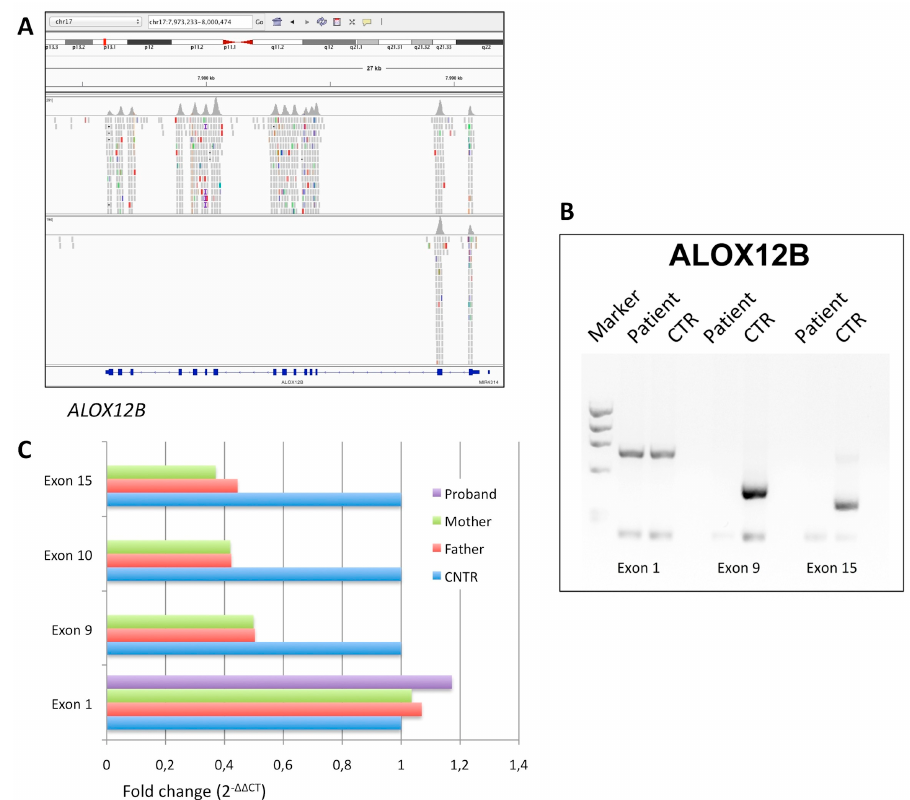
Figure 3. Genetic characterization of patient 3. ( A ) Integrative Genome Viewer detail of the whole ALOX12B gene locus in a control (top view) and in patient 3 (bottom view) revealed the homozygous loss of exon 3 to 15; the average read depth for ALOX12B coding region was about 70X in other patients analyzed. ( B ) Agarose gel electrophoresis analysis of the PCR products obtained for ALOX12B exon 1, 9, and 15, in patient 3 and in a normal control; in the corresponding pairs of lanes, the lower fragments represent an internal control of amplification conditions (see Materials and Methods). ( C ) Gene dosage by real-time qPCR analysis of ALOX12B exon 1, 9, 10, and 15, in patient 3 and in his heterozygous parents; signal quantification is normalized to an autosomal gene sequence and expressed as fold change with respect to a normal control, by using the 2 − ΔΔ Ct method .